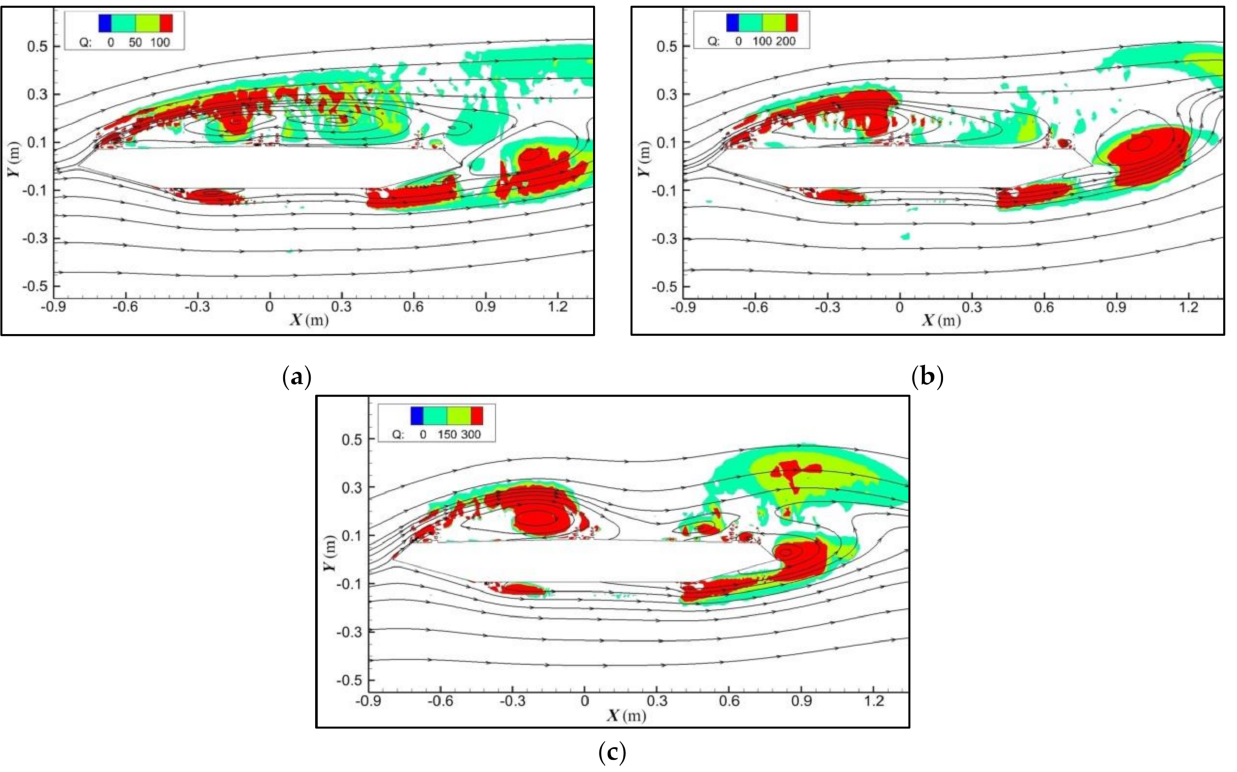
Figure 7. Contours of time-averaged vortex structures at π moment (Unit: s − 1 ). ( a ) Rapid develop- ment stage of VIV. ( b ) Gradual convergence stage of VIV. ( c ) Stable vibration stage of